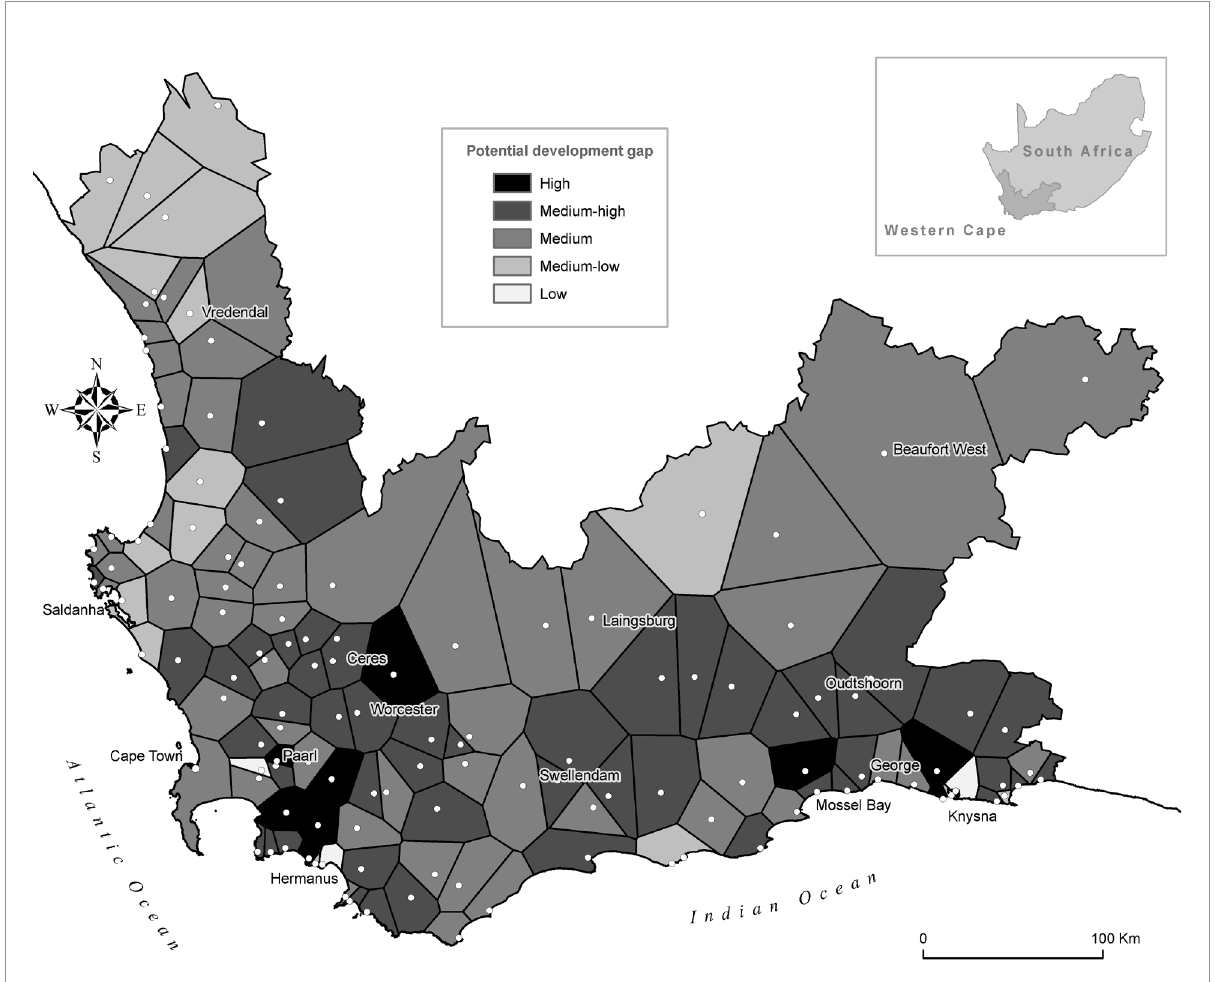
Figure 6: The relative development gap for all tourism products in the Western Cape